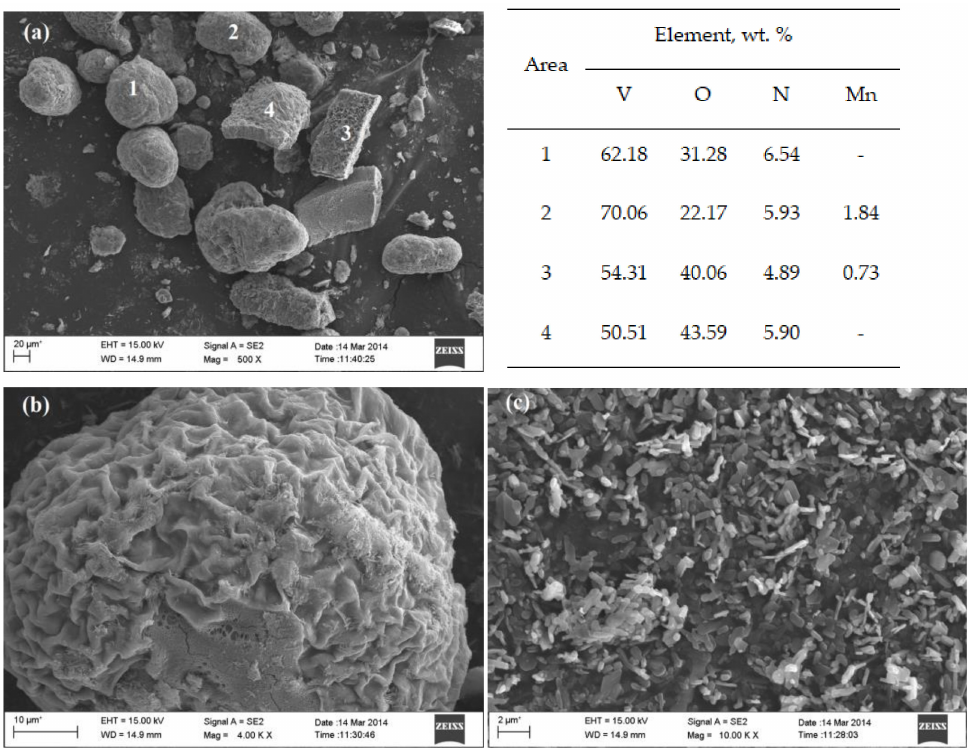
Figure 9. Scanning electron micrographs for ammonium poly-vanadate and vanadium pentoxide powder, ( a ) ammonium poly-vanadate × 500; ( b ) ammonium poly-vanadate × 4,000; ( c ) vanadium pentoxide powder × 10,000.